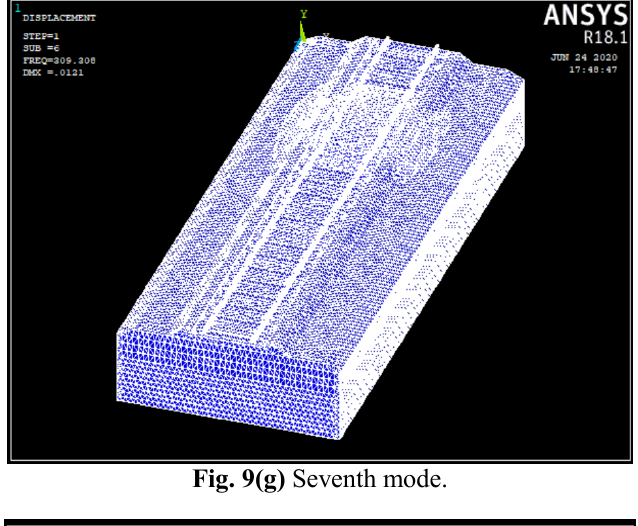
Fig. 9(g) Seventh mode.